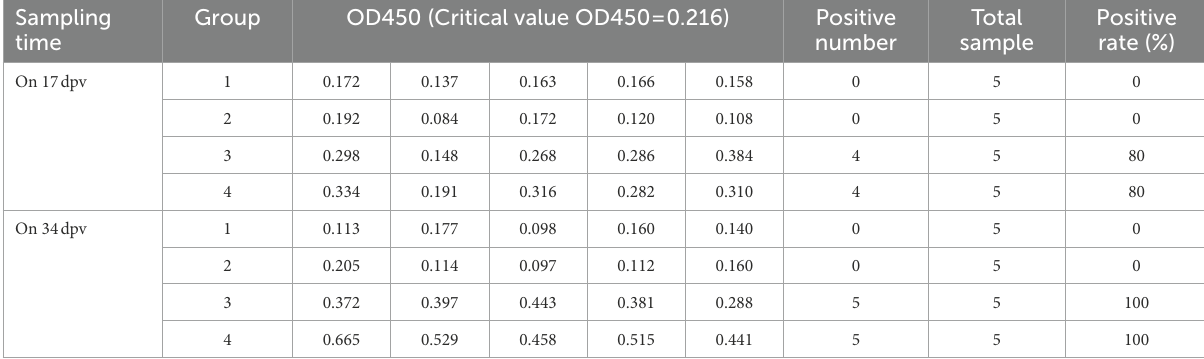
TABLE 3 The levels of p54 IgG antibody in serum of rabbits.